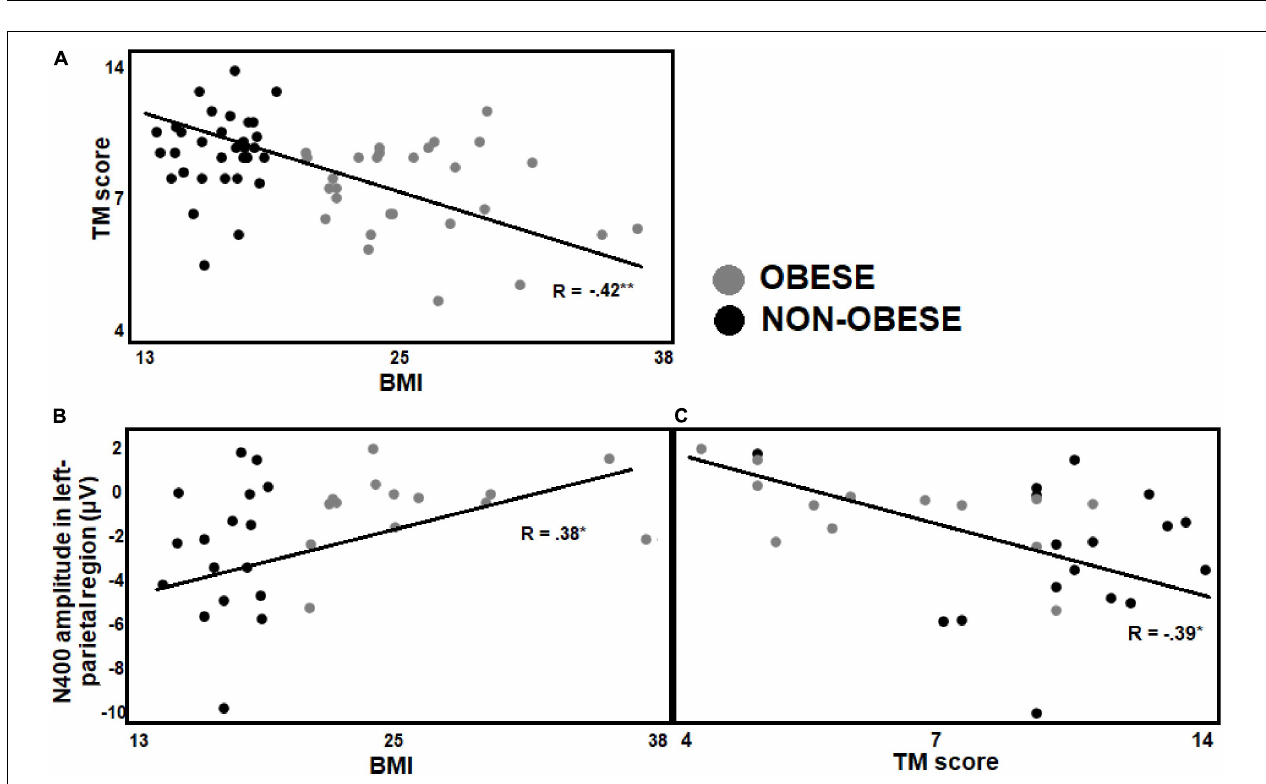
FIGURE 7 | Pearson correlations between BMI, behavioral and electrophysiological data. (A) Illustrates the Pearson correlations between BMI and TM scores in the preteens regardless of math skills level, the BMI negatively correlated with TM scores. (B,C) Show Pearson correlations in the preteens with low math skills. (B) Illustrates a positive correlation between BMI and N400 amplitude in left parietal ROI, and (C) a negative correlation between TM score and N400 amplitude in this same ROI. Significant p -values were represented as follows: * p < 0.05, ** p <